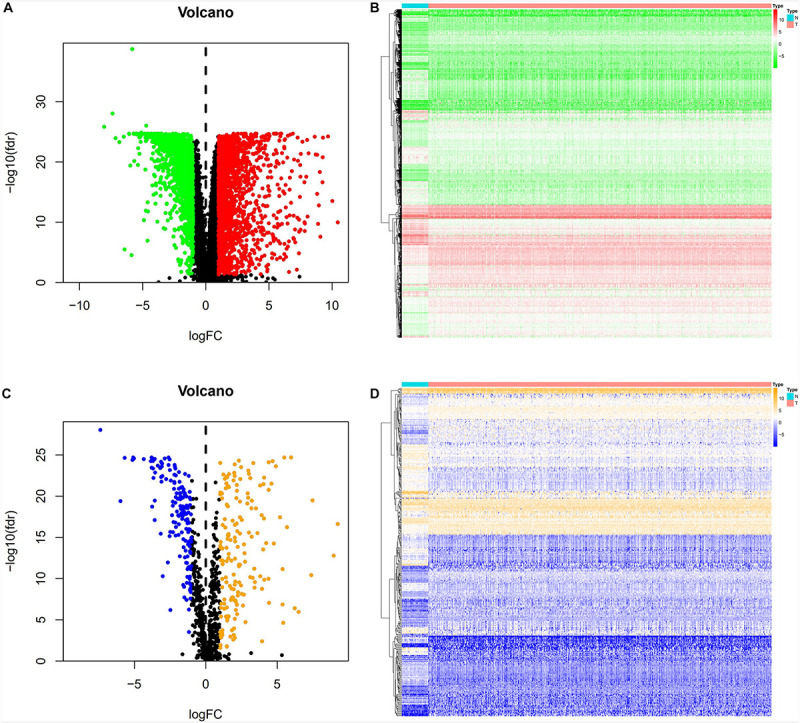
DEGs and immune-related DEGs in CRC. (A) Volcano plot of DEGs. The red dots represent the upregulated genes and the green dots represent the downregulated genes in CRC. Black dots represent no statistical significance. (B) Heatmap of DEGs. The process from low to high expression of each gene is shown by the color from green to red. (C) Volcano plot of immune-related DEGs. The orange dots indicate the upregulated genes and the blue dots indicate the downregulated immune-related genes in CRC. (D) Heatmap of immune-related DEGs. Orange represents higher expression while blue represents lower expression in CRC.